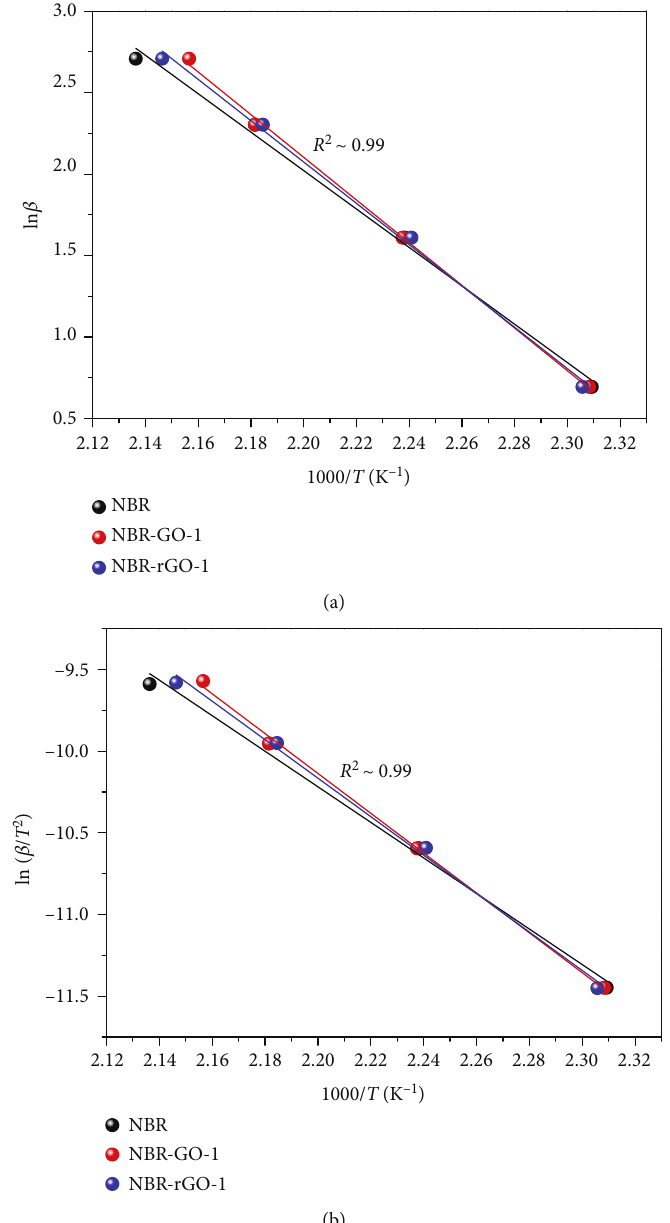
Figure 7: The Ozawa (a) ln β versus 1000/ T , and Kissinger (b) ln ( β / T 2 ) versus 100/ T plots for the determination of energy of activation ( E for curing of non-activated NBR and its nanocomposites (NBR –